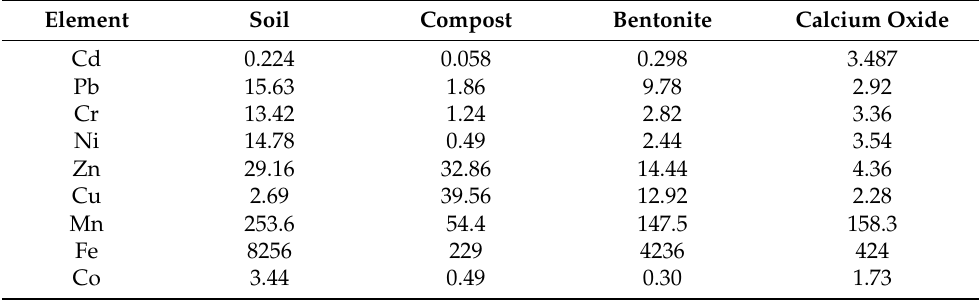
Table 1. Total content of heavy metals in soil and material amendments (mg kg − 1